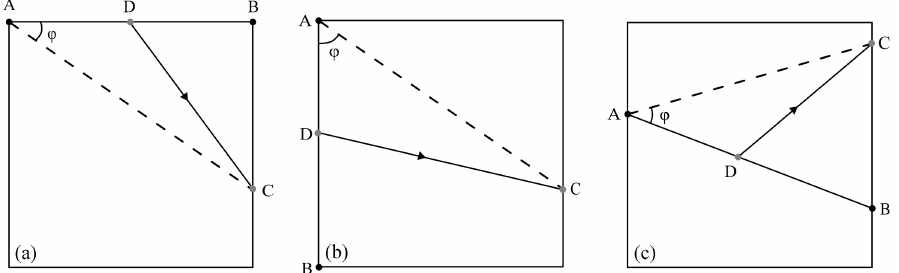
Figure 3. Sketch map of computing the traveltime of point C and the coordinate of point D by the linear interpolation method ( a ) on the horizontal boundary, ( b ) on the vertical boundary, and ( c ) inside the grid on line AB . The arrows represent the raypath from point D to point C, the dotted lines AC represent the auxiliary line in triangle ADC, and ϕ represents the angle between line AB and line AC